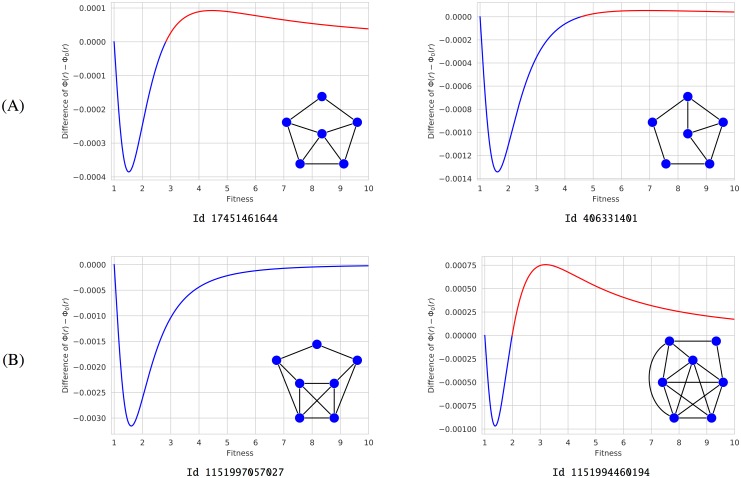
Suppressors that become amplifiers.(A) Examples of order 6 from [11] with a unique transition at rc ≈ 2.82 and rc ≈ 4.56 respectively. (B) Examples of order 7 from [6] having a unique transition at rc ≈ 79.15 and rc ≈ 1.98 respectively. In both cases, we use identification numbers from [11] to facilitate any search in our database. Each graph is shown with the function Φ(r) − Φ0(r), which has been symbolically computed.